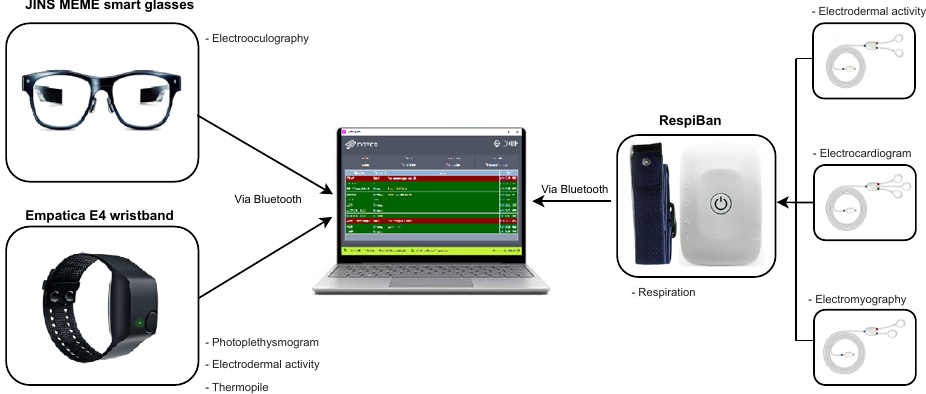
Figure 2. The SenseHunger system uses three sensory devices, namely, JINS MEME smart glasses, Empatica E4 wristband, and RespiBan. The Electrodermal activity (EDA), Electrocardiogram (ECG), and Electromyography (EMG) electrodes are plugged into the RespiBan device. Datasets from all devices are sent to the laptop for storage using a Bluetooth